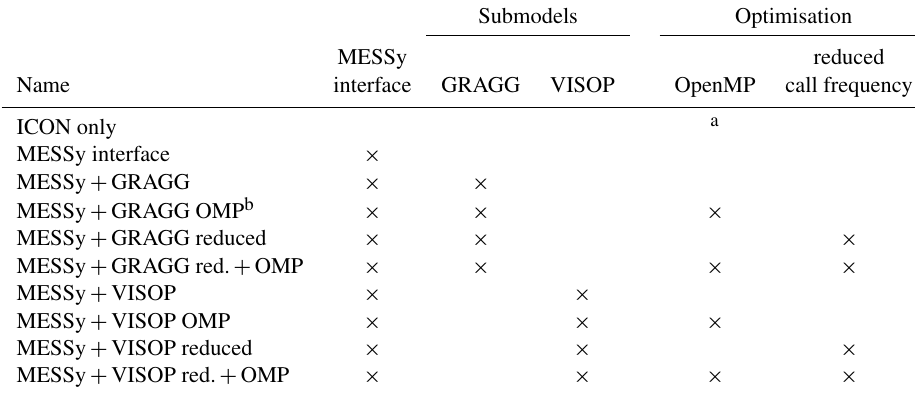
Table 1. Overview of the test cases for the performance tests. Submodels Optimisation MESSy reduced Name interface GRAGG VISOP OpenMP call frequency ICON only a MESSy interface